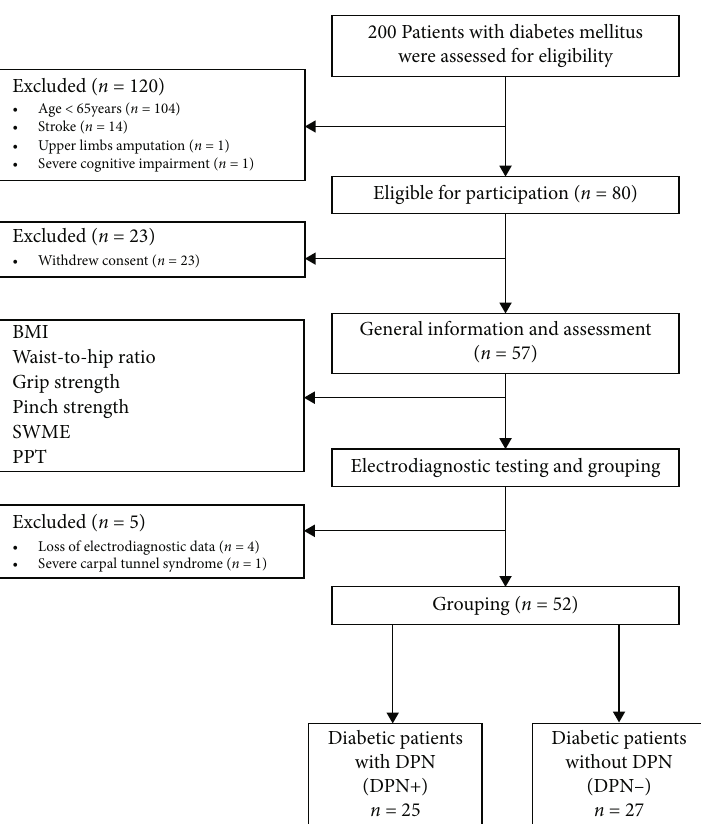
Figure 1: Participant inclusion criteria and research procedure. SWME: Semmes Weinstein mono fi lament examination; PPT: Purdue Pegboard Test.